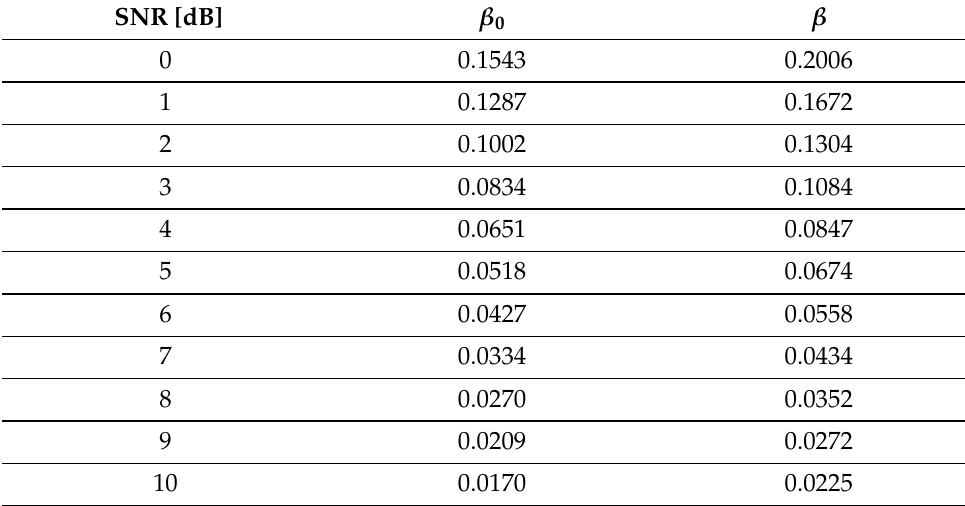
Table 4. Average β 0 and selected β value over 500 Trials with Respect to SNR. Two emitters at 60 ◦ and 63 ◦ , 100 snapshots.